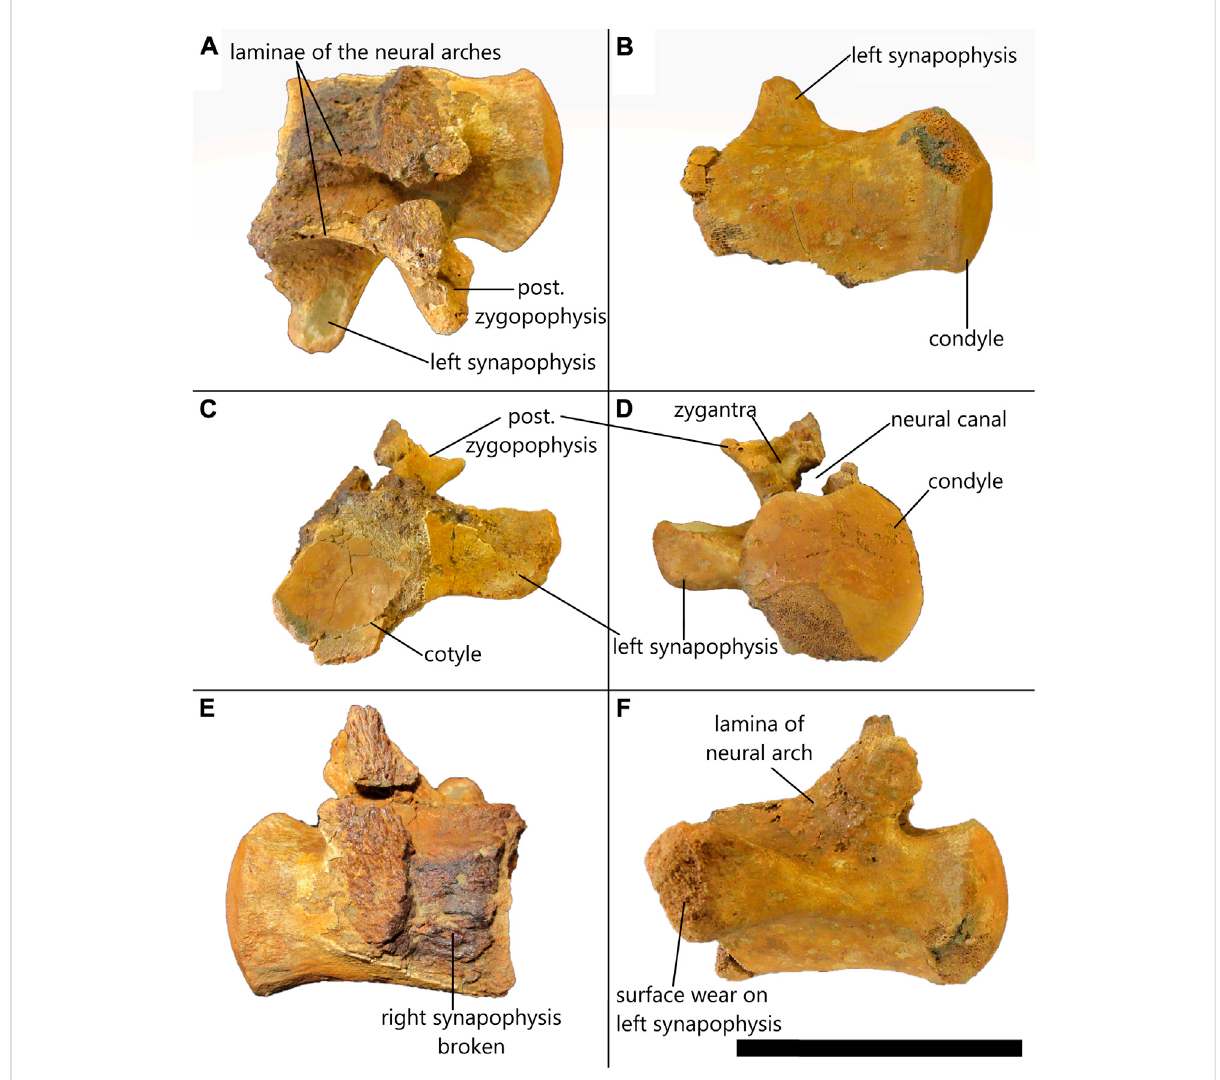
FIGURE 12 Indeterminate partial mosasaurid dorsal vertebra from St. Lucia in (A) dorsal, (B) ventral, (C) anterior, (D) posterior, (E) right lateral, (F) left lateral view. Scale bar = 80